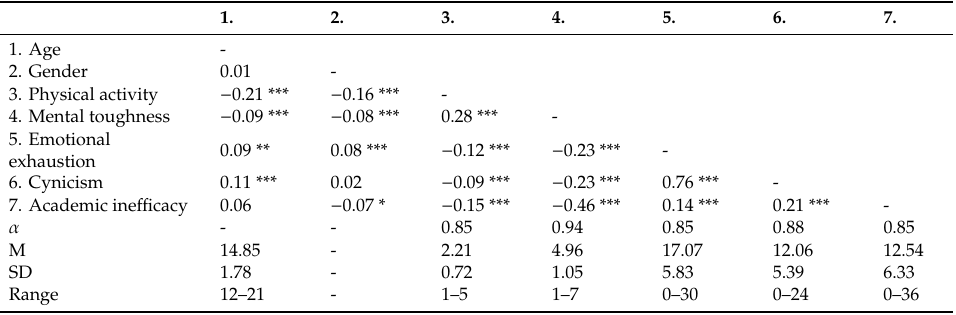
Table 1. Descriptive statistics, internal reliability, and zero-order correlations of the study variables ( n =